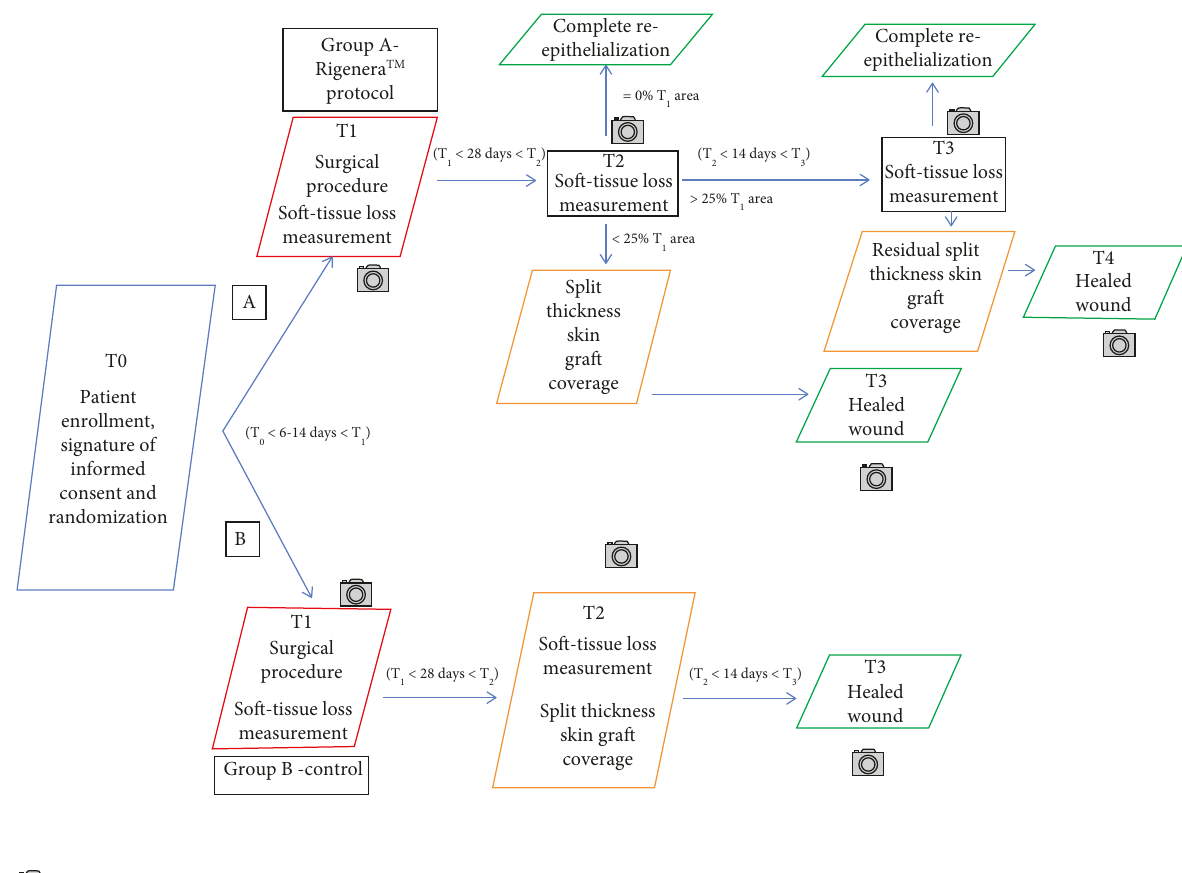
Figure 1: Scheme of the overall study